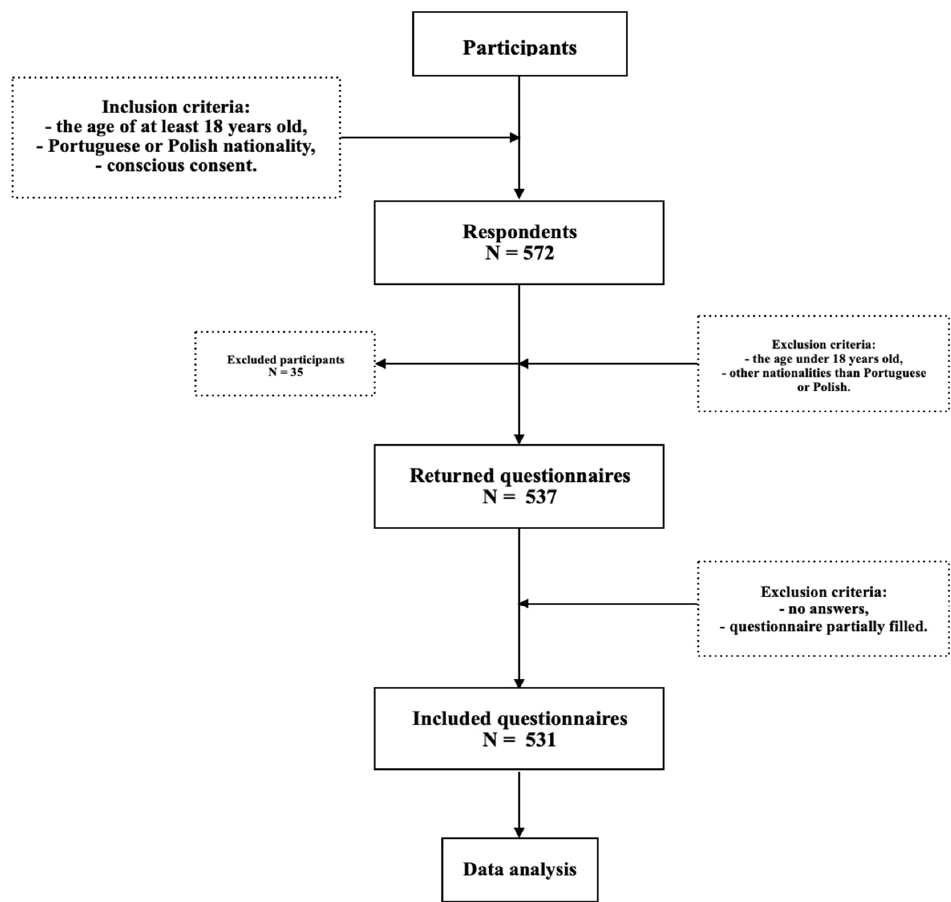
Figure 1. Flowchart: study design and data collection (N—number of participants).